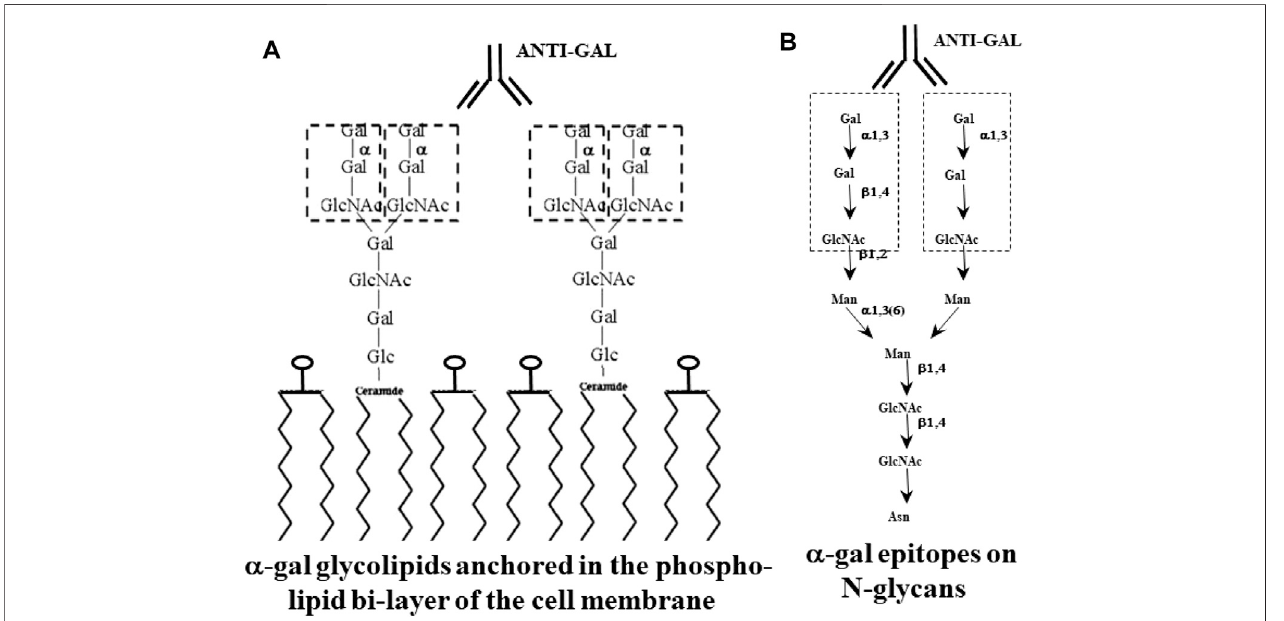
FIGURE 1 | Glycans with α -gal epitopes on glycolipids (A) and glycoproteins (B) . The α -gal epitopes are marked with dashed line rectangles. Glycans of glycoproteinsaresynthesizedwhentheaminoacidsequence(sequon)withinaprotein isasfollows:asparagine – anyaminoacid – serineorthreonine(N – X – S/T).Glycans of the “ complex ” type on glycoproteins have 2 – 4 branches (antennae). Glycolipids comprise glycans linked to a ceramide that is anchored in the membrane by its fatty acid “ tail ” . Glycans of glycolipids may have 1 – 8 branches. α -Gal epitopes on both glycoproteins and glycolipids bind the natural anti-Gal antibody. Gal, galactose; Glc, glucose; GlcNAc, N-acetylglucosamine; Man, mannose; N, asparagine; S, serine; T, threonine; X, any amino acid. Adapted from Galili U. The natural anti-Gal antibody as foe turned friend in medicine. Publishers Academic Press/Elsevier, London, 2018, with